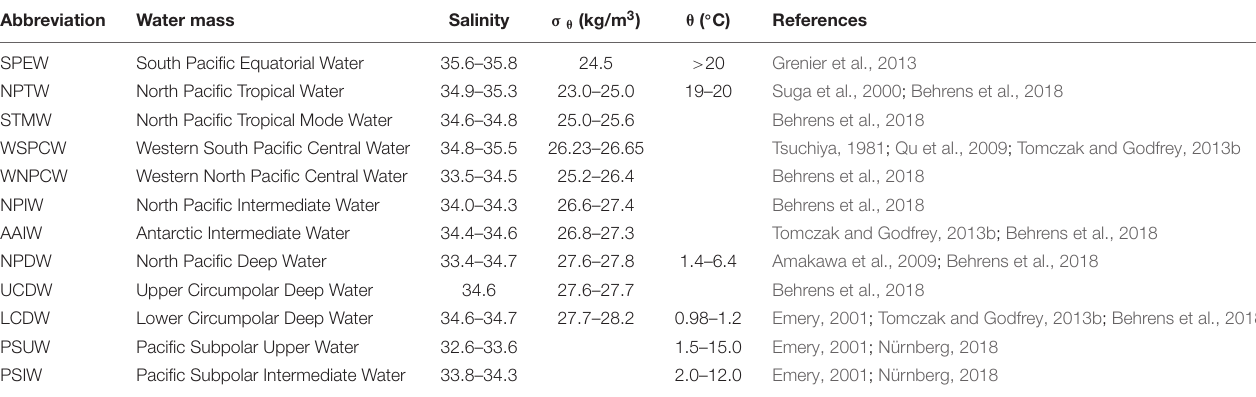
TABLE 1 | Water masses discussed in this study and their hydrographic